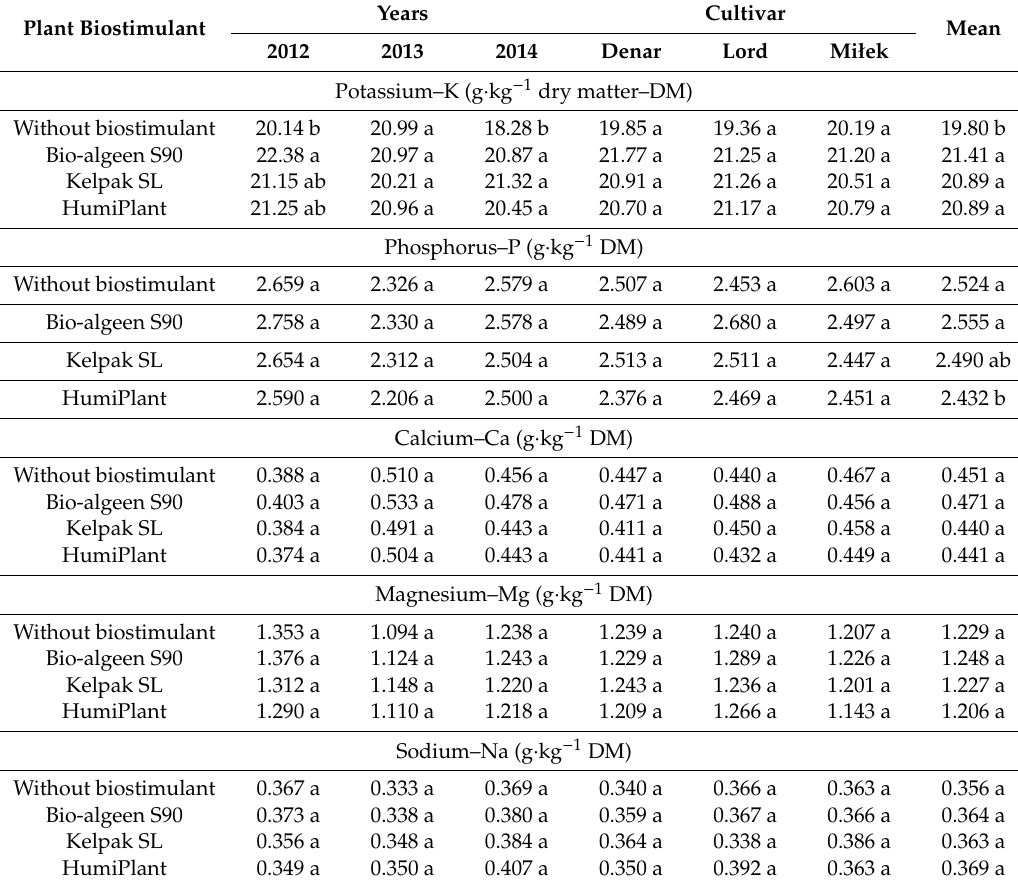
Table 3. Macronutrient content in potato tubers in relation to plant biostimulant. Plant Biostimulant